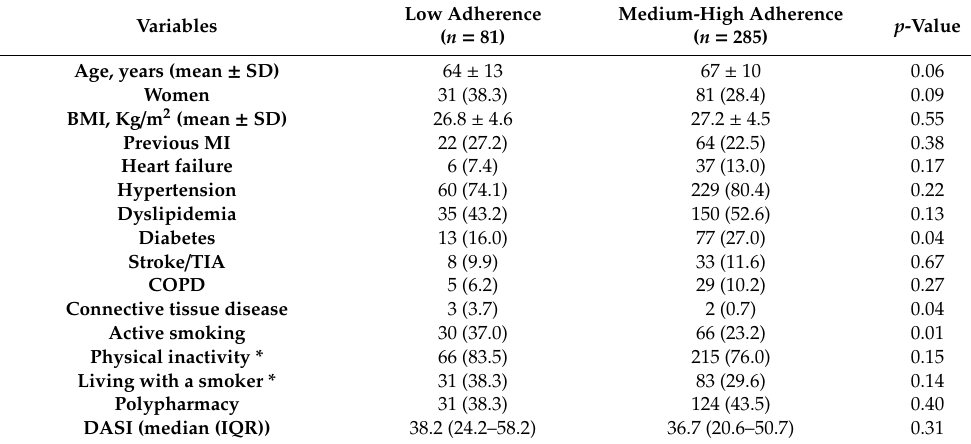
Table 1. Baseline clinical characteristics of (Endocrine Vascular Disease Approach) EVA project participants according to the adherence to the Mediterranean diet.